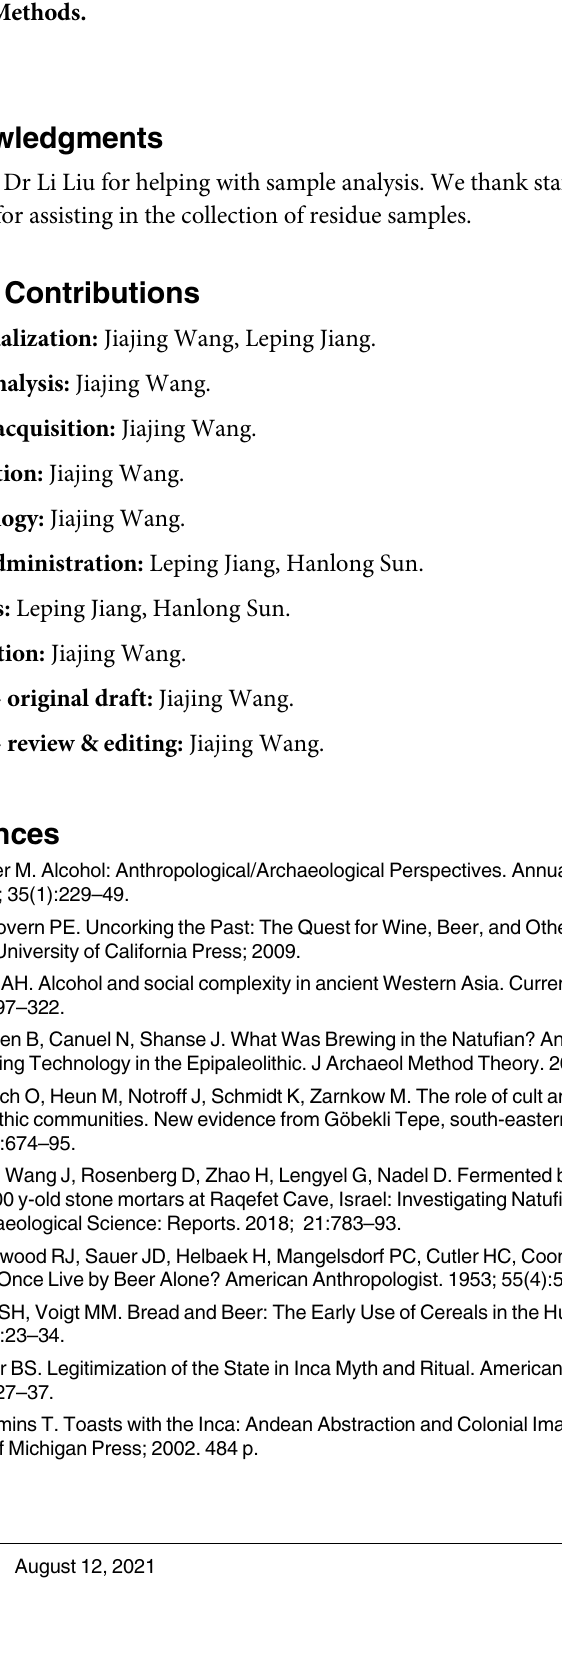
S1 Table. Phytolith data from Qiaotou